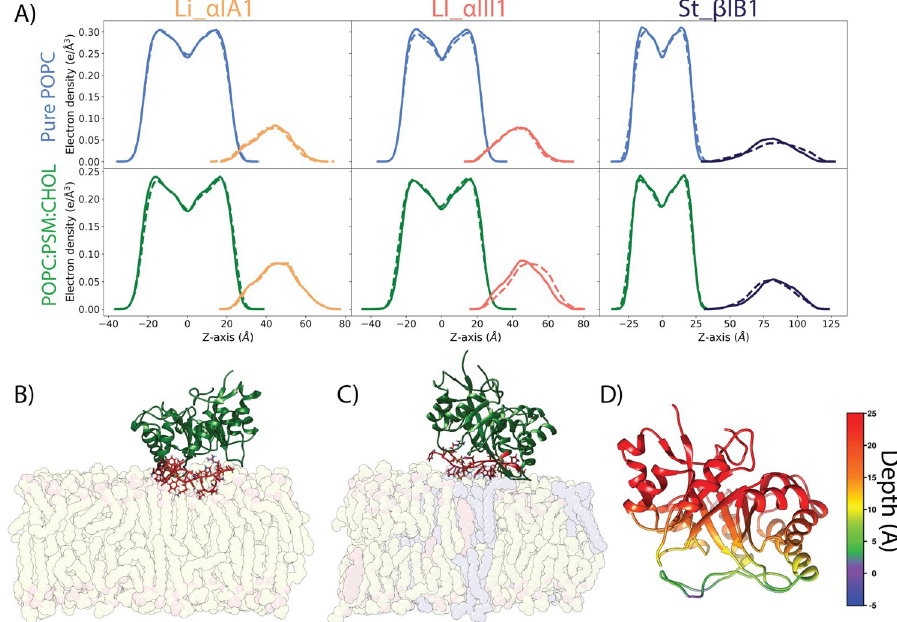
Fig 3. Li_ α IA1 and Ll_ α III1 bound to POPC and POPC:PSM:CHOL (70:20:10). A) Electron density plots for Li_ α IA1, Ll_ α III1 and St_ β IB1 on the POPC bilayer (top row) or on the POPC:PSM:CHOL bilayer (bottom row), replica 1 (solid lines) and replica 2 (dashed lines). The densities for the POPC and POPC:PSM:CHOL bilayers are represented in light blue and green, respectively. The density distributions for the proteins are represented in orange (Li_ α IA1), pink (Ll_ α III1) and dark blue (St_ β IB1). B) Bound orientation of Li_ α IA1 on a pure POPC bilayer. C) Binding orientation of Ll_ α III1 on a POPC:PSM:CHOL bilayer. D) Depth of anchorage of Li_ α IA1 into the POPC bilayer. The depth is calculated for each amino acid as the distance between its C-alpha and the phosphate plane in the last frame of simulation (relevant values are given in Tables A and B in S2 Text).